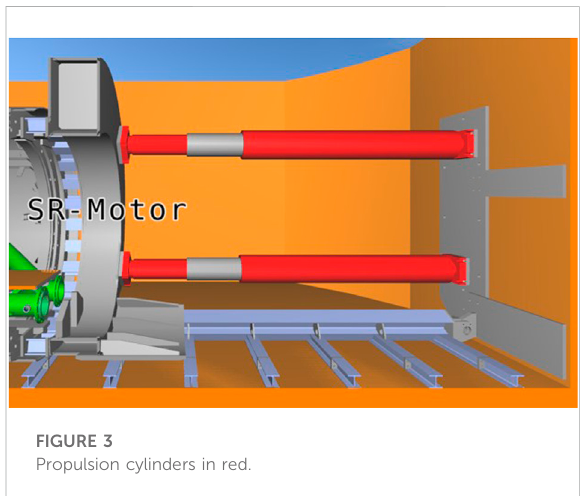
FIGURE 3 Propulsion cylinders in red.